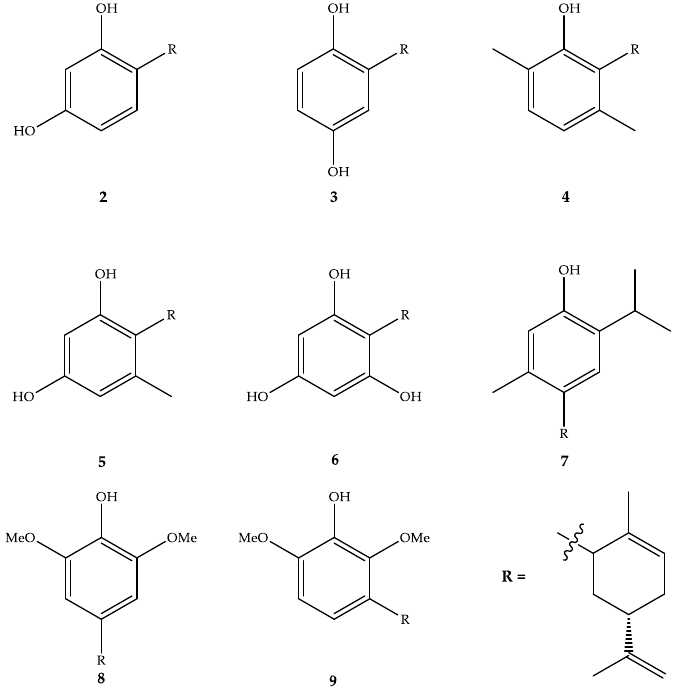
Figure 1. Structure of the carveoylphenols.